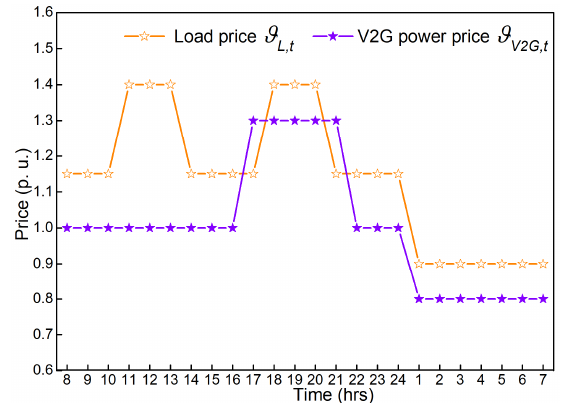
Figure 8. Price signals for simulation.